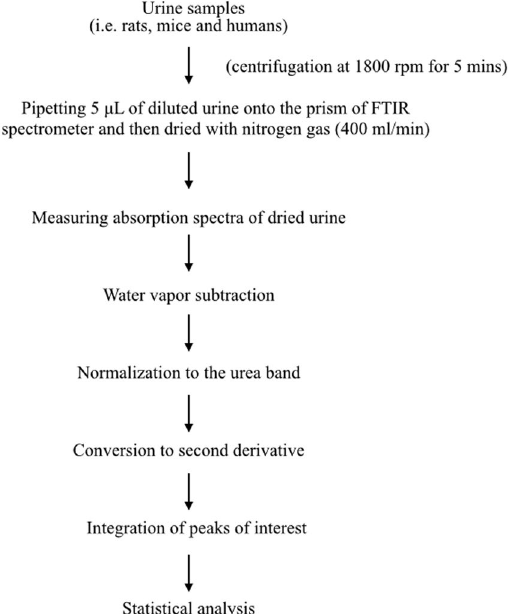
Figure 2. Protocol for urine handling and analysis. Urine is firstly centrifuged and the supernatant is diluted with distilled water and a 5 μ l sample is dried on to the ATR prism surface. After drying, a sample spectrum is recorded. The raw sample spectra are pre-processed by water vapor subtraction, normalization to the peak of urea and second derivative conversion. Features of interest are then quantitated by integration and statistical assessment (Origin Pro